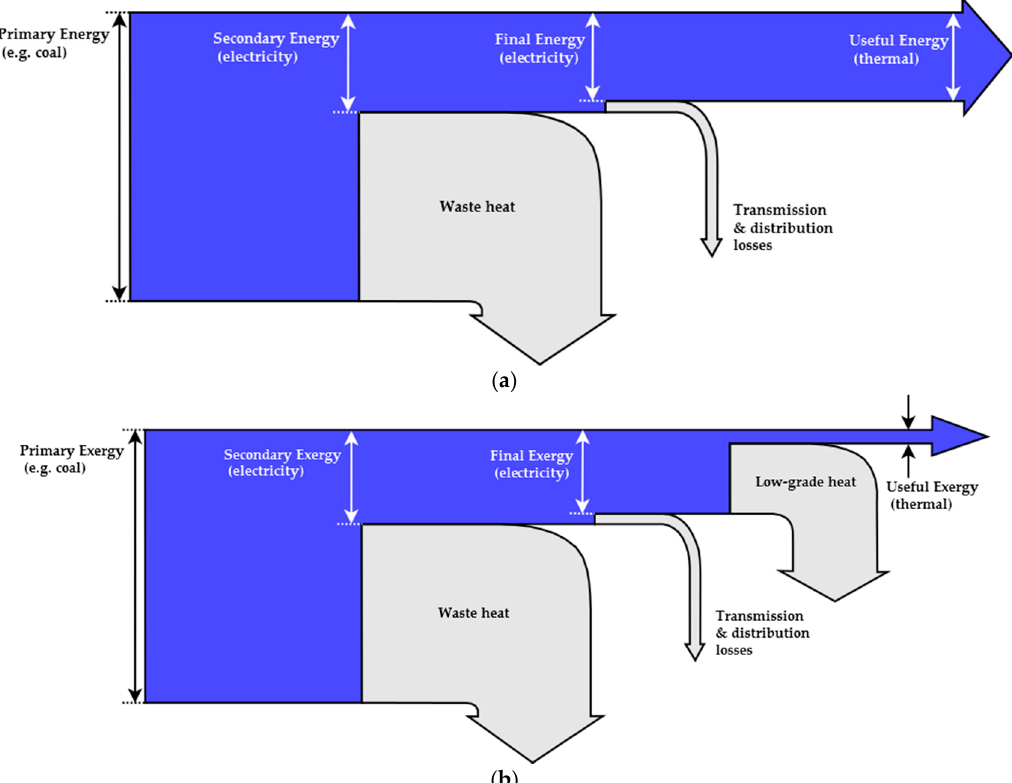
Figure 1. Example of ( a ) energy and ( b ) exergy losses from the primary to useful stages of conversion in an electric space heater.